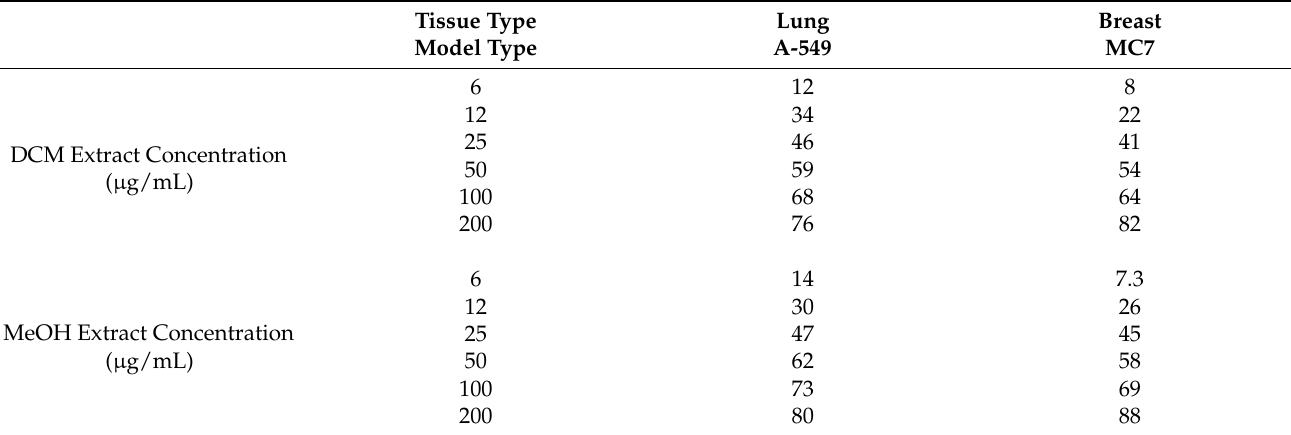
Table 4. In vitro anticancer activity by LDH assay of N. mexicana Zucc.